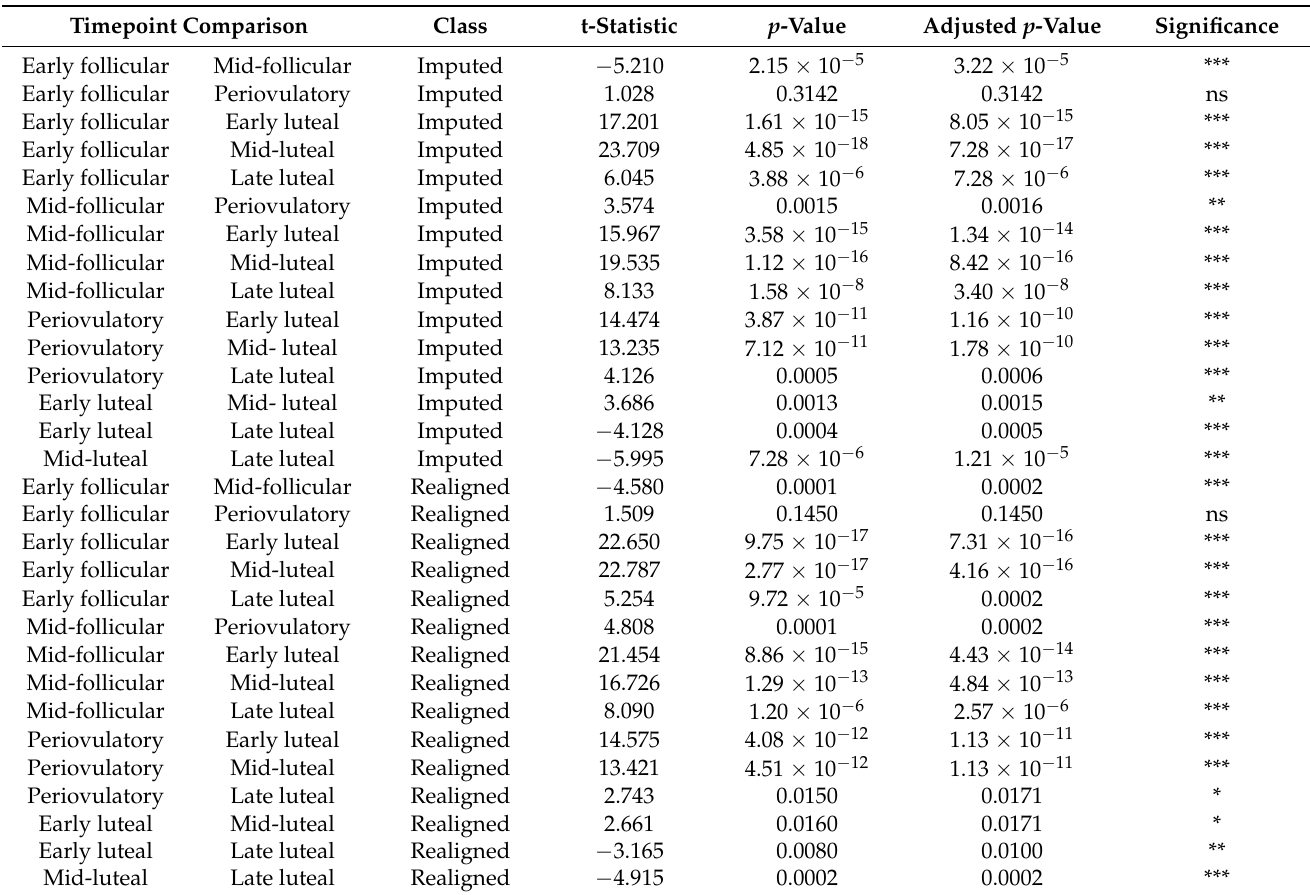
Table 3. Allopregnanolone: progesterone ratio subphase